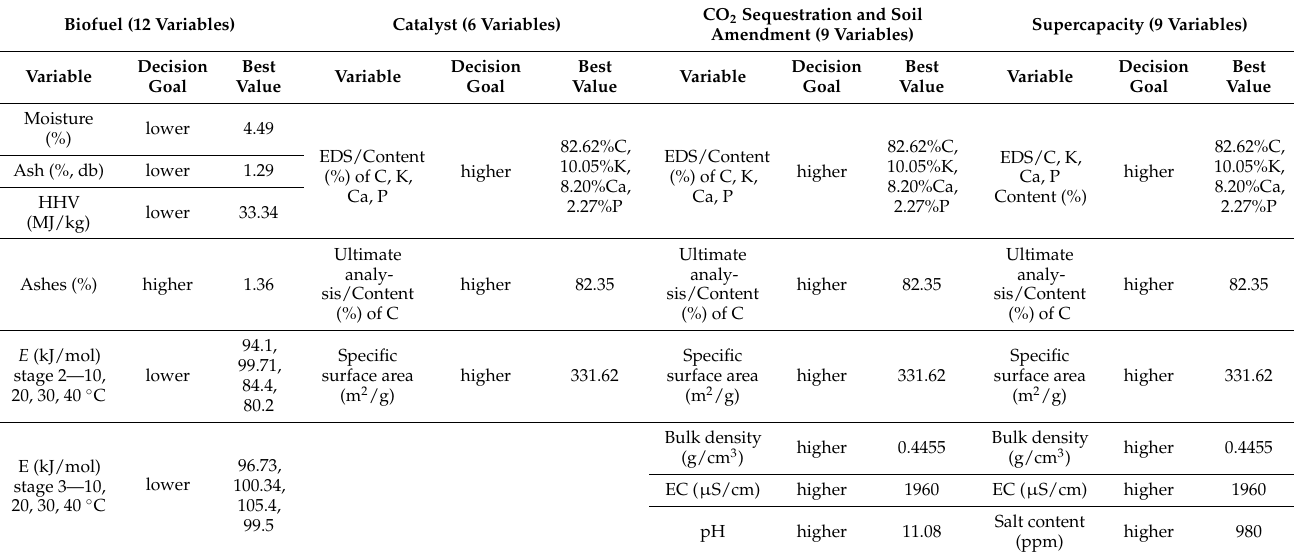
Table 1. Decision variables for each